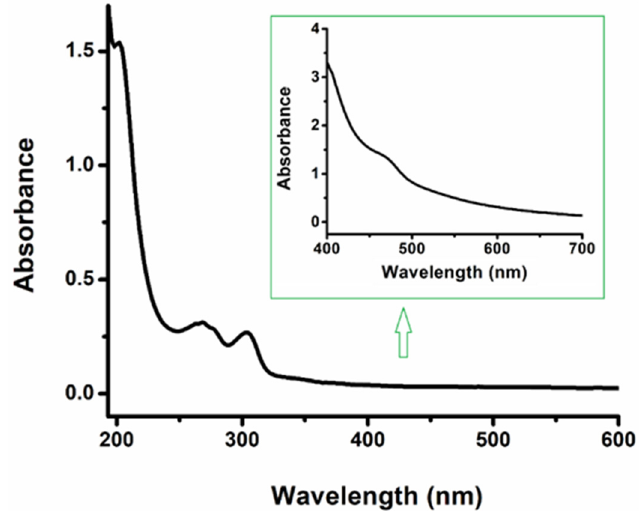
Figure 2 . UV–Vis absorption spectra of complex 3 measured in CH 3 CN (conc: 5 × 10 − 6 M; Inset conc: 5 × 10 − 3 M).